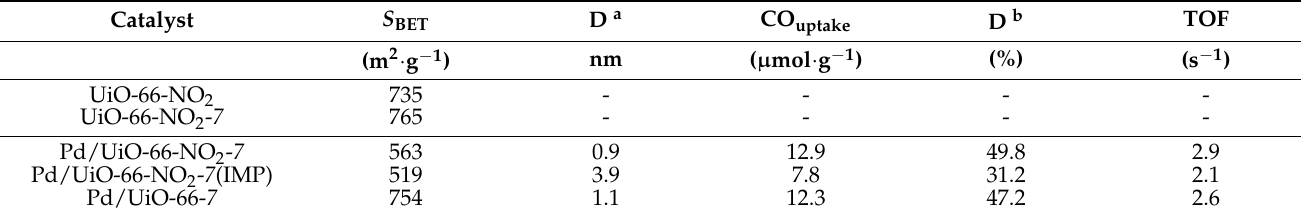
Table 1. The structural properties, metal dispersion, metal particle size and TOF of Pd-catalysts. Catalyst